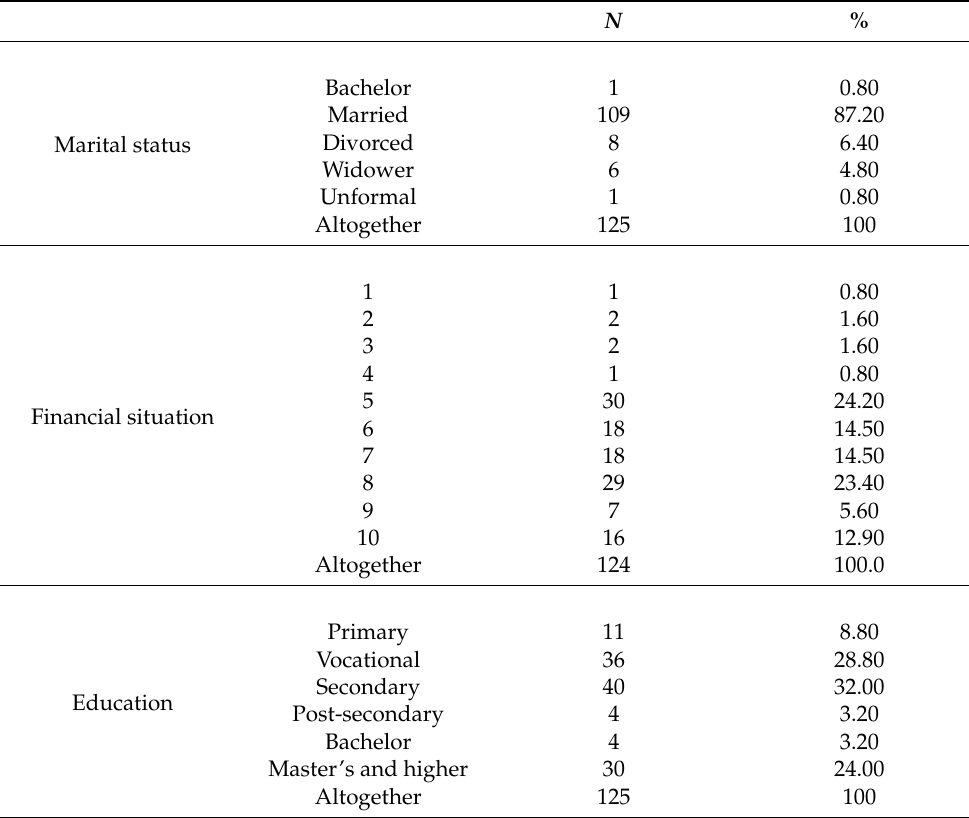
Table 1. Demographic